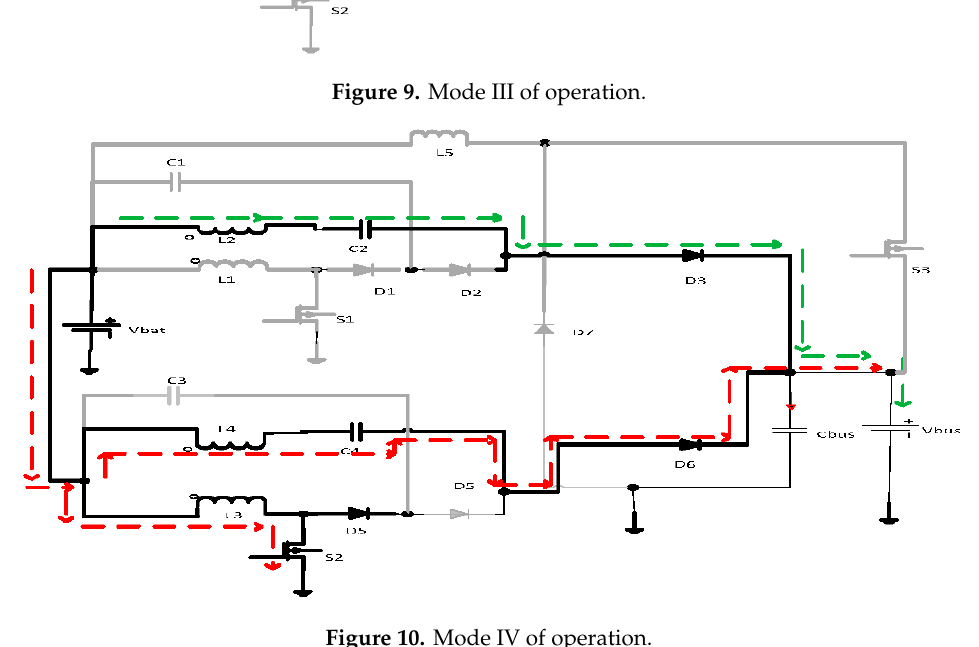
Figure 10. Mode IV of operation.